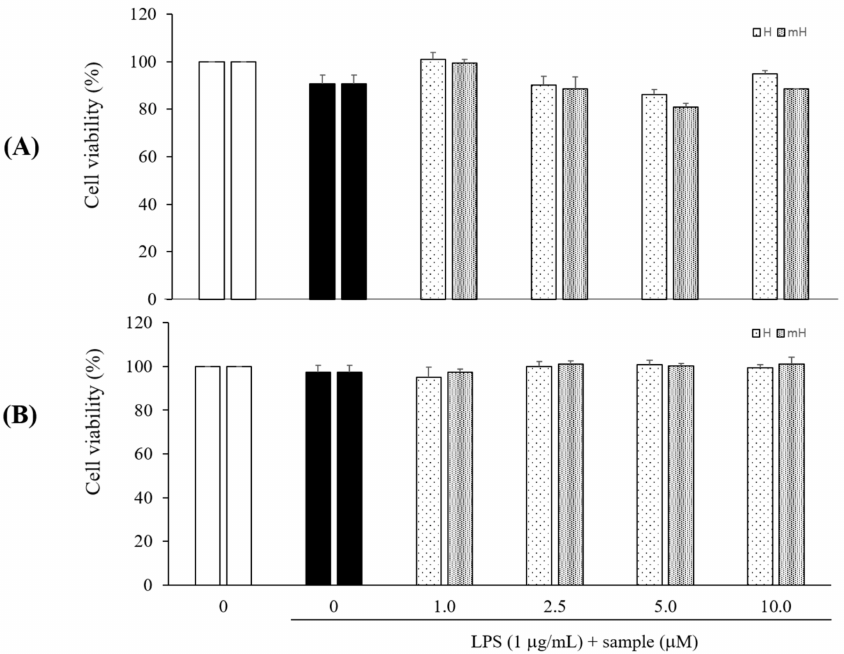
Figure 3. Effects of H and mH on cell viability in LPS-induced RAW 264.7 ( A ) and HT-29 cells ( B ). Cells were cultured in the presence of H and mH for 1 h and stimulated with LPS (1 µ g/mL) for 24 h under serum-free conditions. Cell viabilities were determined using CCK-8 assay. Each determination was made in triplicate. Data are presented as means ±